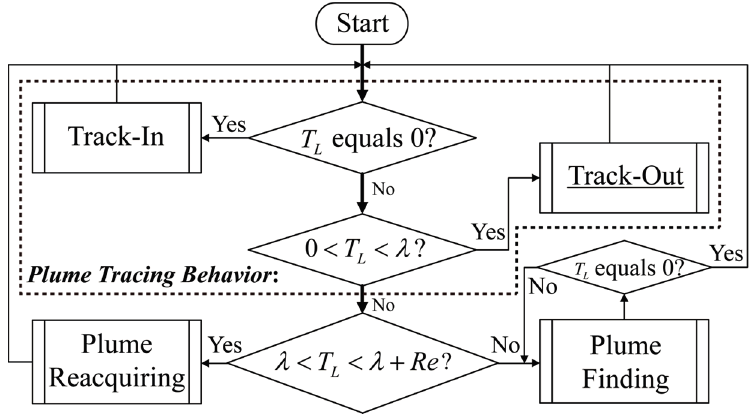
Figure 1. Circulation process following the first chemical detection